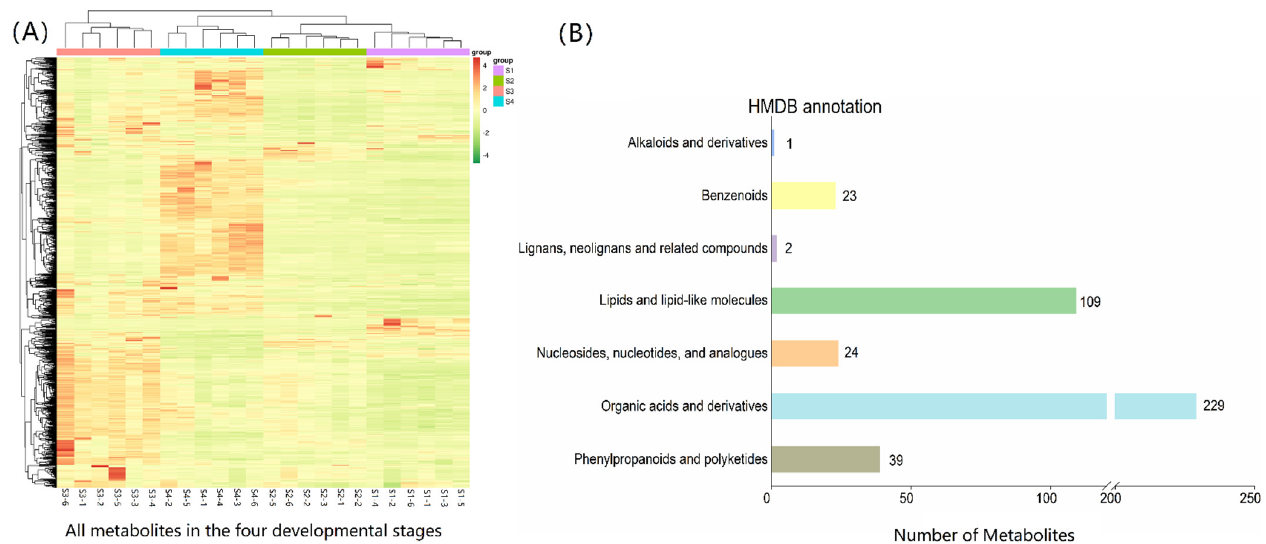
Figure 5. Classification of metabolites according to annotation. ( A ) Hierarchical clustering analysis of metabolite expression for all samples. ( B ) Metabolites classified by HMDB database. of metabolite expression for all samples. ( B ) Metabolites classified by HMDB